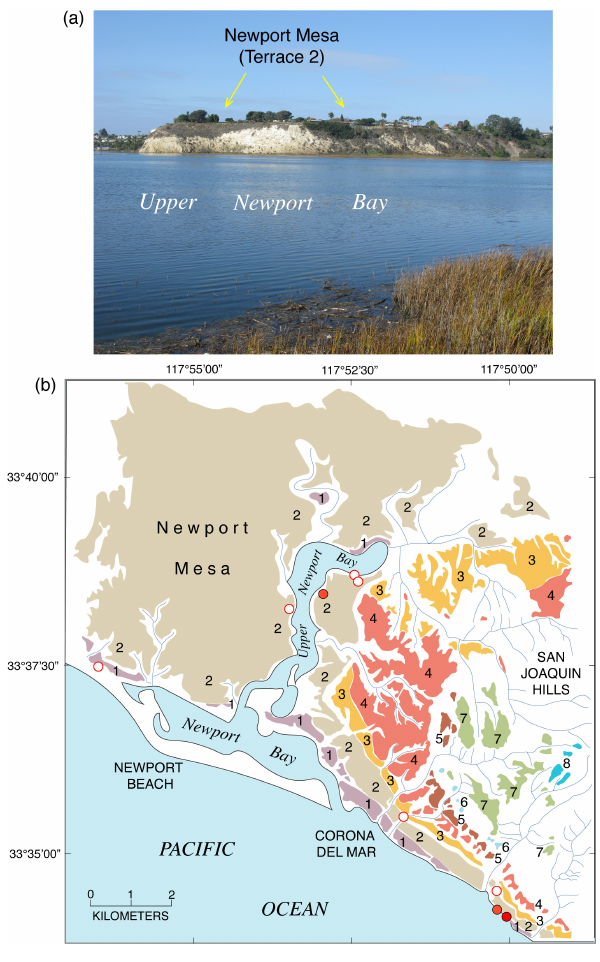
Figure 28. (a) Photograph of Newport Mesa (terrace 2) of MIS 5e age, view to the west, upper Newport Bay in the foreground. (b) Map of marine terraces in the Newport Bay area, redrawn from Vedder et al. (1957, 1975) and Grant et al. (1999); terrace elevations and ages increase with terrace numbering (terrace 1 = youngest; terrace 8 = oldest). Filled red circles are fossil localities with U- series ages from Grant et al. (1999); open red circles are amino acid geochronology fossil localities of Wehmiller et al. (1977b). Photo- graph in (a) by Daniel R. Muhs.